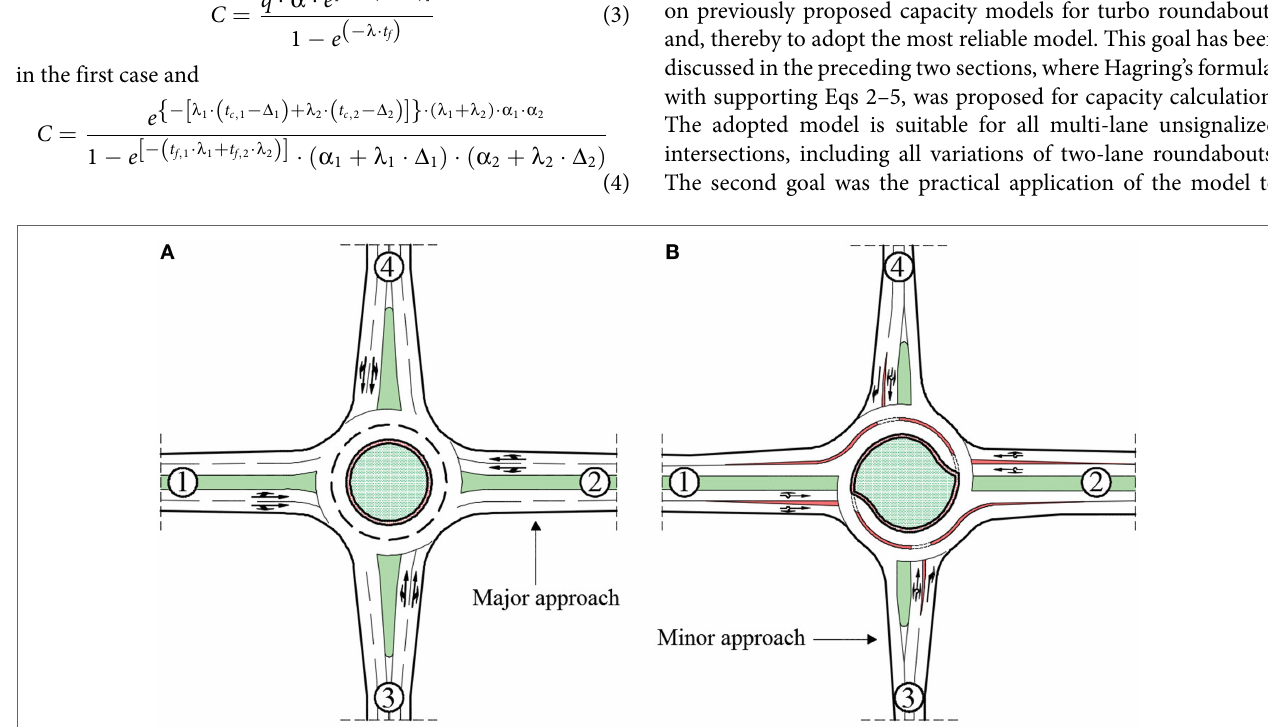
FIGURE 1 | Conventional two-lane roundabout (A) , and standard turbo roundabout (B) (Vasconcelos et al., 2014a).